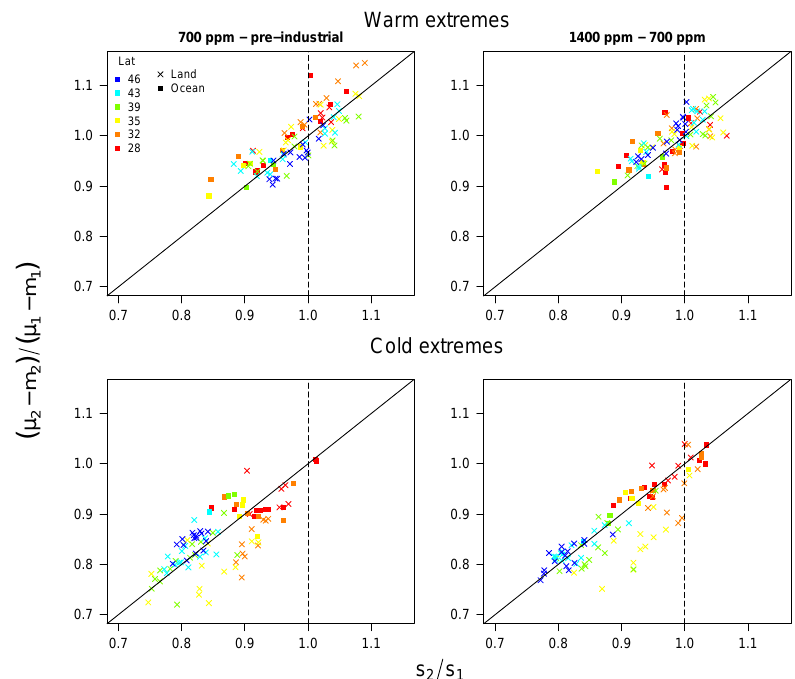
Figure 5. Assessment of whether changes in the location parameter of extremes are linked to changes in mean ( m ) and standard deviation ( s ) of the corresponding seasonal distributions. Left: ratio of differences between GEV location parameter and seasonal mean compared to ratio of within-season standard deviations, for the transition from pre-industrial (climate state 1) to 700ppm CO 2 (climate state 2). Right: same results with climate state 1 corresponding to 700ppm and state 2 to 1400ppm. Scatterplots show these terms for all locations in study area, for warm extremes in upper panels and for cold extremes in lower panels. Plots show that µ 2 − m 2 is very well approximated by ( µ 1 − m 1 ) s 2 /s 1 , where s 2 /s 1 is the ratio of within-season standard deviations.